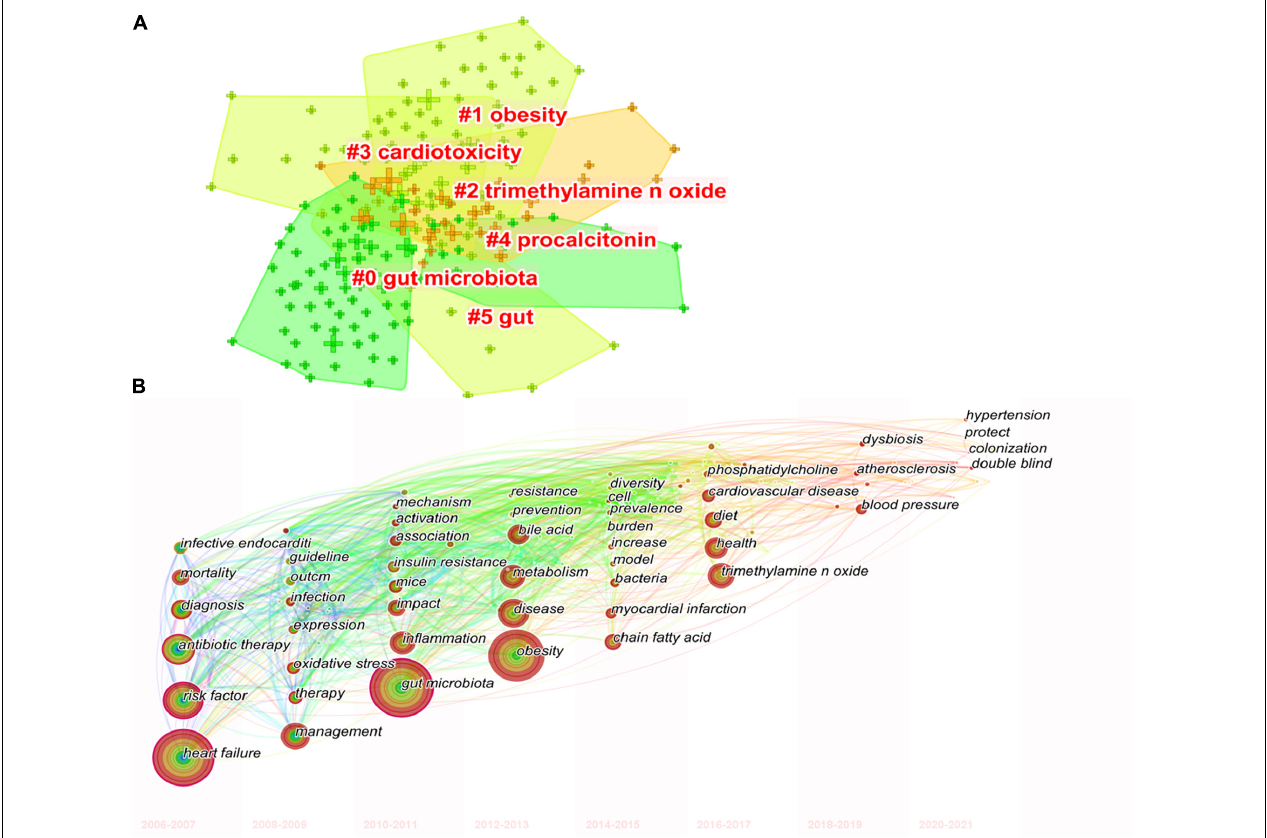
FIGURE 7 | The keywords clustering knowledge map for research of gut microbiota in the heart failure field from 2006 to 2021. (A) Clustering visualization map of the co-occurring keywords, labeled with the largest six clusters. (B) Time-zone view of co-occurring keywords, with the size of each node proportional to the frequency of keyword